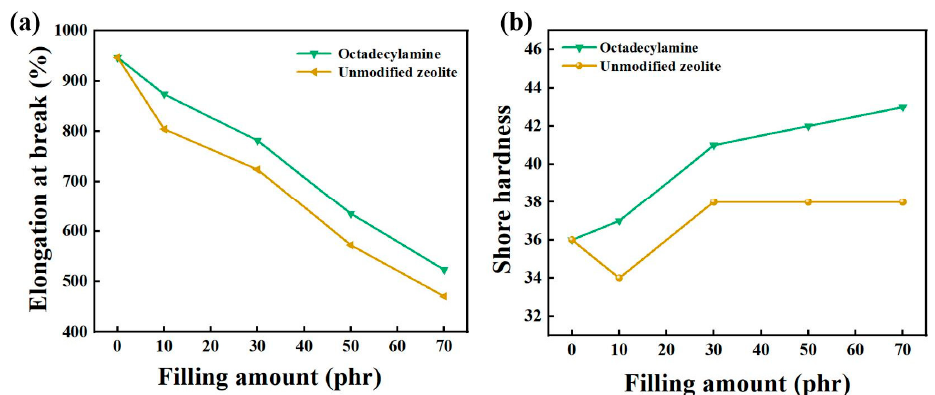
Figure 4. The effect of filling amount on elongation at break ( a ) and Shore hardness ( b ).